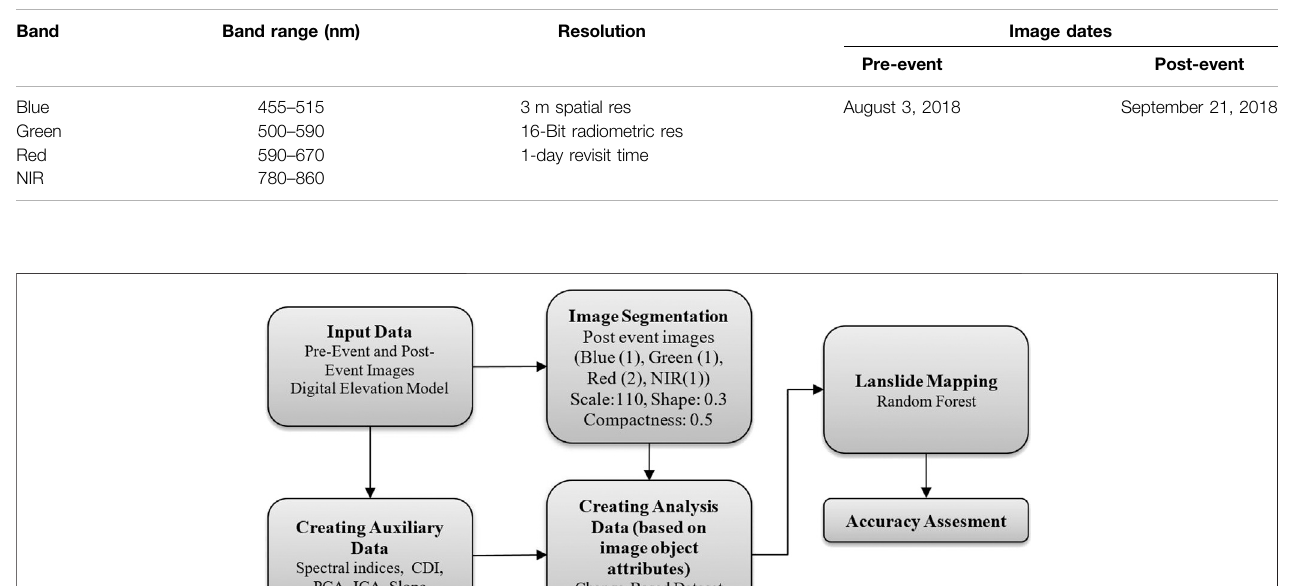
TABLE 1 | PlanetScope Leve 3 B product speci fi cation and image dates.